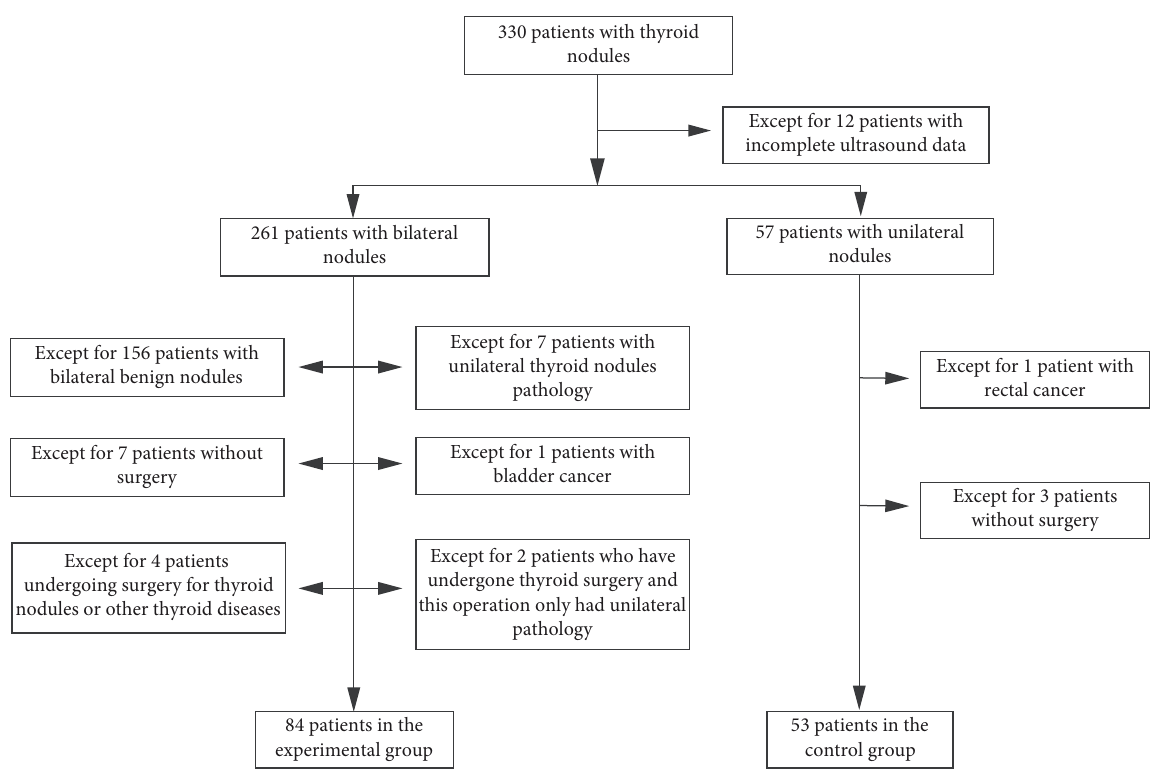
Figure 1: Flowchart of review and grouping of the study. Table 1: Distribution of thyroid nodule TI-RADS classification.